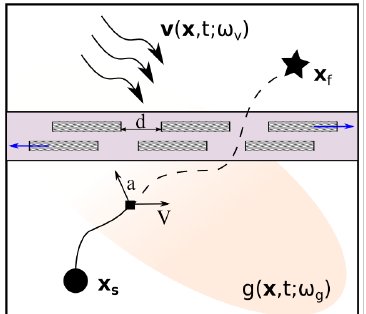
Figure 6. Schematic of the shipping channel crossing problem: The purple region is the shipping chan- nel that ships use for traversing across the domain. Thin horizontal striped boxes represent the ships (obstacles). The ships in the top and bottom queues move eastwards and westwards,